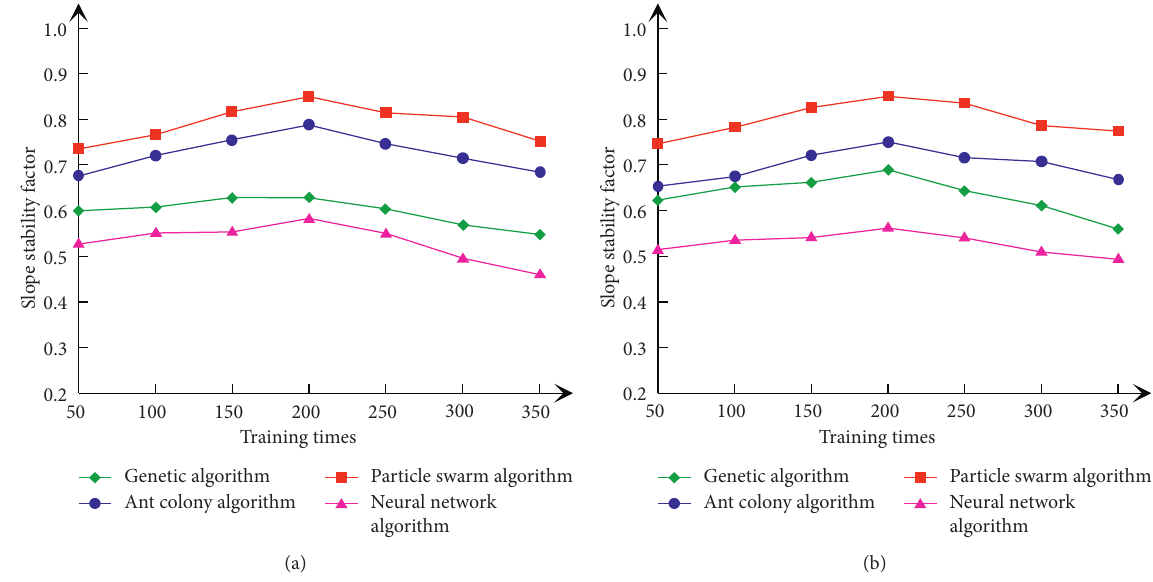
Figure 7: Slope stability factor of different artificial intelligence algorithms in the limit equilibrium method (a) and finite element method